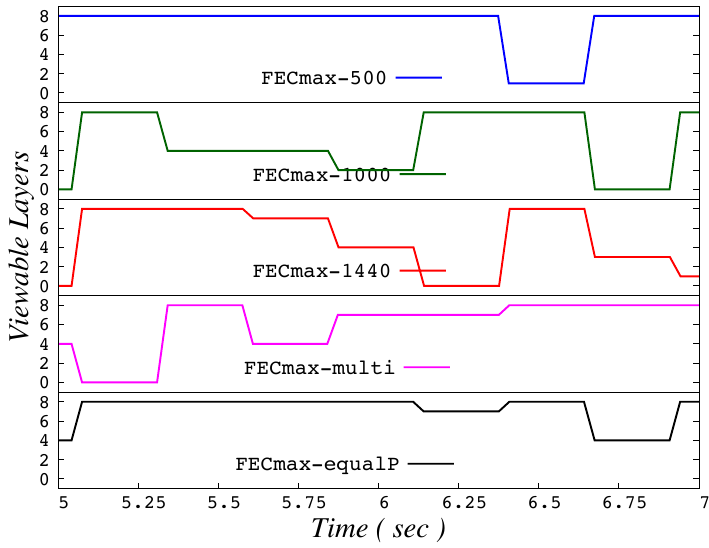
Figure A12. A two-second example of variation in viewable quality for all FEC max schemes, at a packet loss rate of 10% and a GOP of